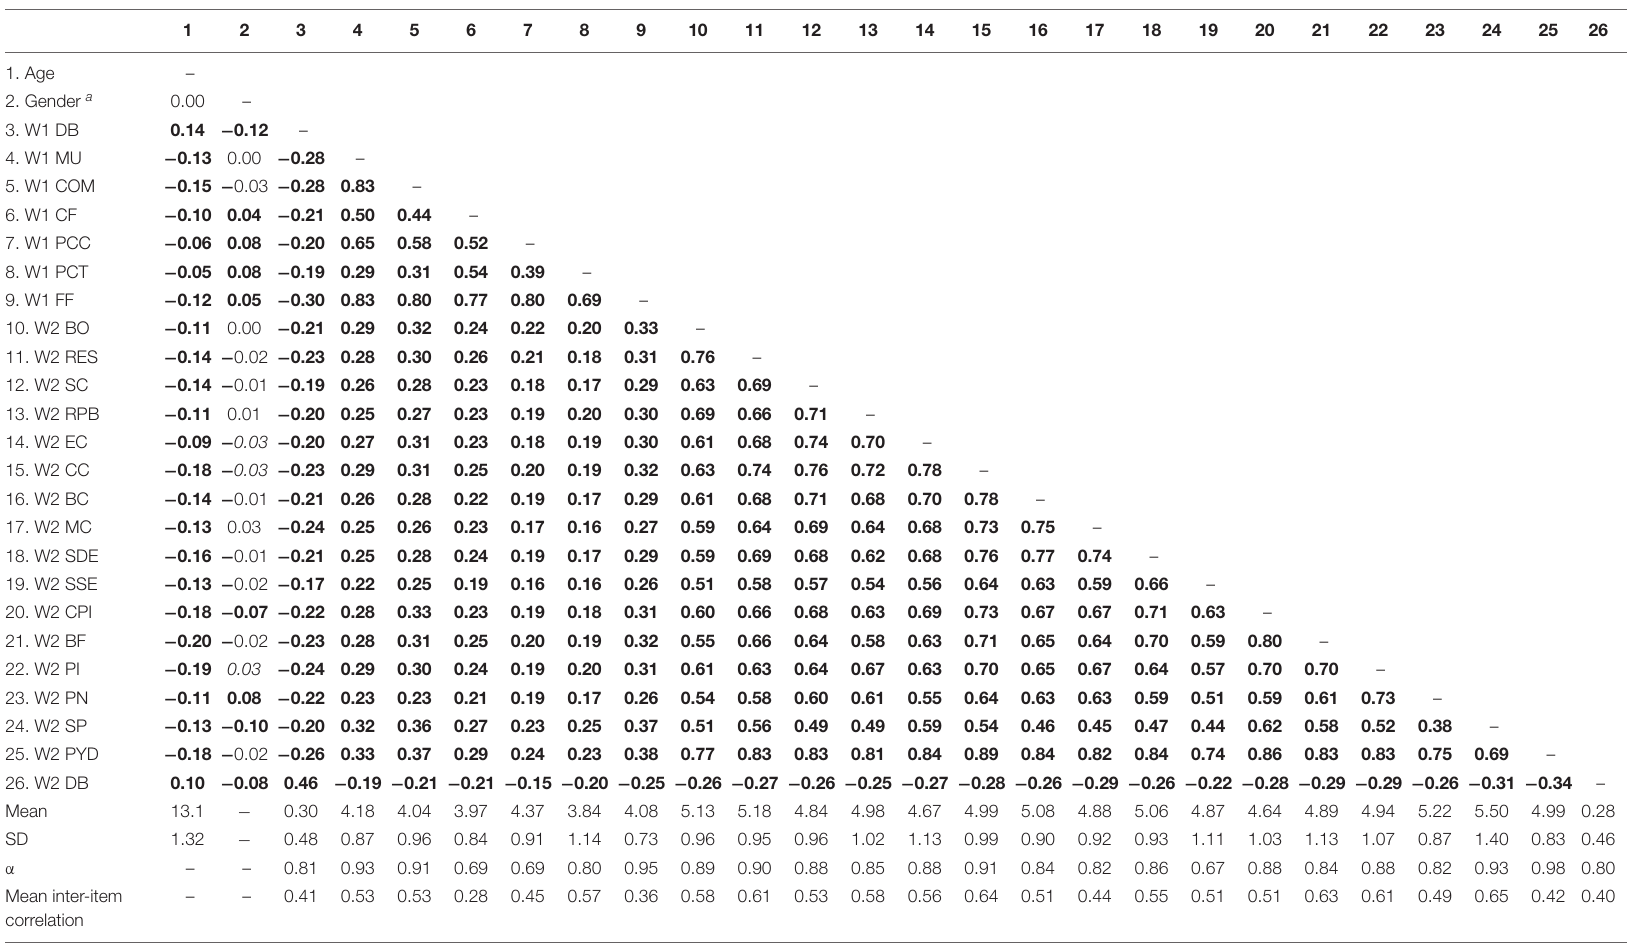
TABLE 1 | Descriptive statistics, reliability, and inter-correlation of study variables ( N =